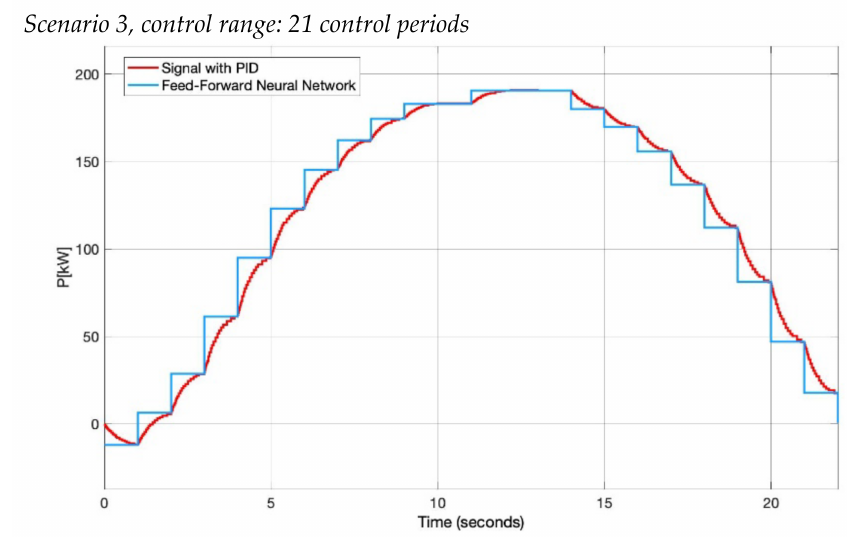
Figure 25. Control signal for BESS, p.f. = 1, R—week.